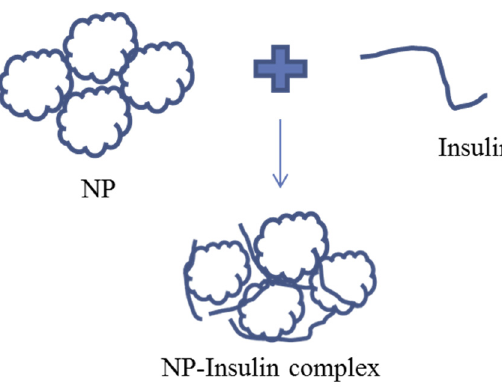
Figure 2. A simplified illustration of insulin loading into particles .